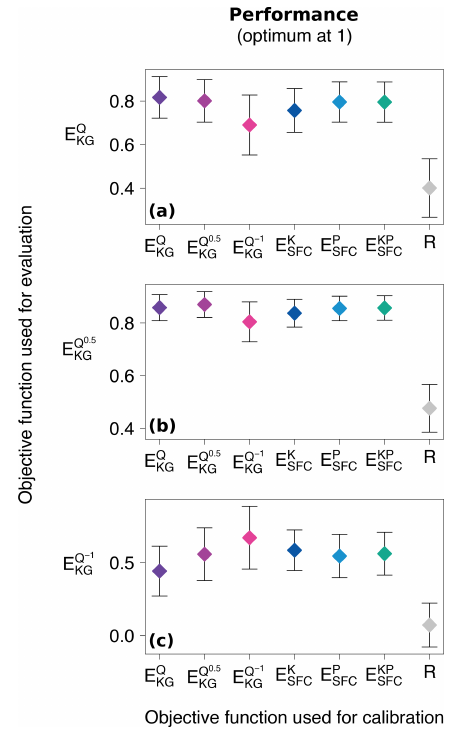
Figure 5. Comparison of the overall performance in evaluation of the model calibrated with the six objective functions. The three tra- ditional objective functions are used as evaluation efficiencies. E Q corresponds to the original Kling–Gupta efficiency (Gupta et al.,